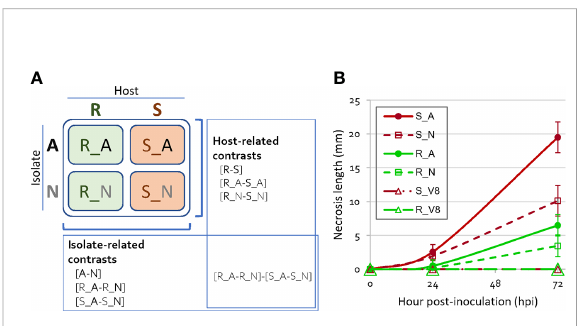
FIGURE 1 Experimental design of the four host-isolate interactions and disease symptom progression. (A) Scheme of the four host- isolate interactions and the seven contrasts considered in DiCoExpress for detecting differentially expressed genes of Phytophthora capsici . Three biological replicates were produced per host-isolate interaction. A, adapted isolate; N, non-adapted isolate; V8, mock inoculation; R, resistant host; S, susceptible host. (B) Disease symptom progression over 72 hpi on resistant and susceptible peppers inoculated with an adapted and a non- adapted isolates of P. capsici . Each dot shows the mean of 16 plants for S and of 24 plants for R. Error bars show the standard deviation. ANOVA test, at 24 hpi p-value=2.28 10 -14 (R²=0.58), at 72 hpi p-value=4.18 10 -39